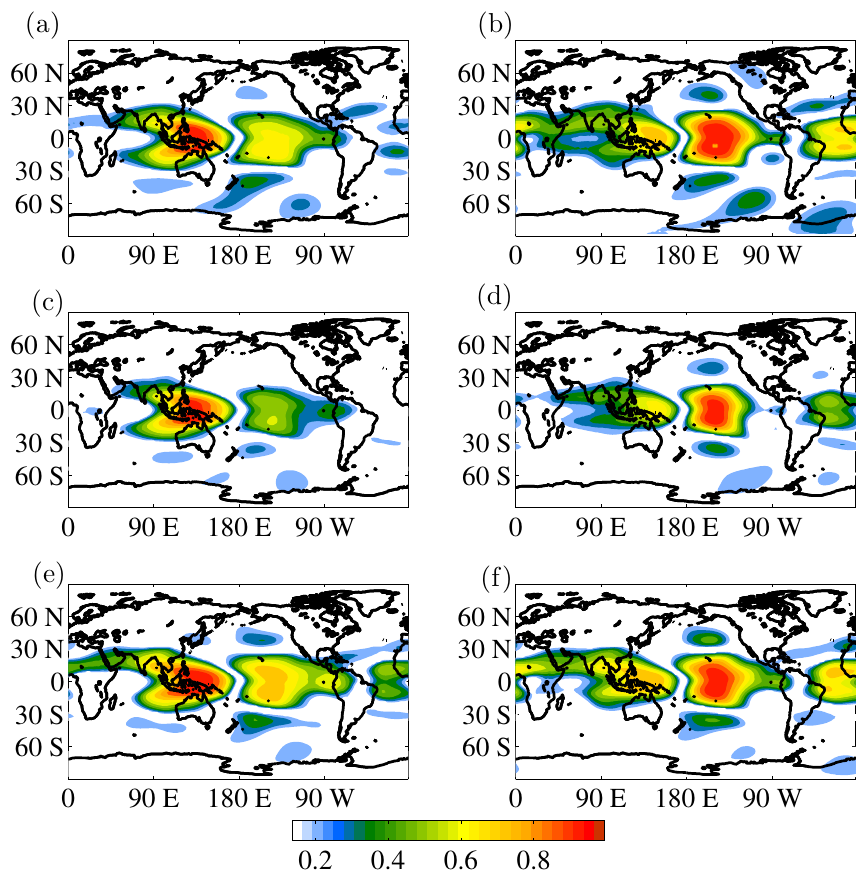
Figure 8. Maps of the cross-correlation using the NOAA data. The color represents the mean value of the PC of each location, with the WP and CP boxes (defined in the text) taking 30-year windows centered at 1915, 1940 and 1995. (a) and (b) correspond to 1915, WP and CP, respectively, (c) and (d) to 1940, WP and CP, respectively, and (e) and (f) to 1995, WP and CP,